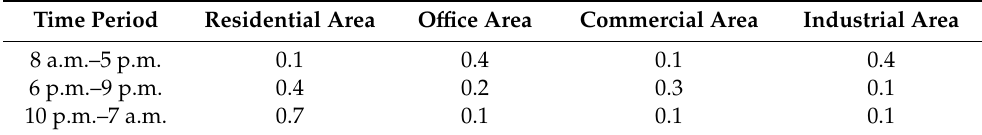
Table 2. Distribution probability of electric vehicles (EVs) in each time period for different functional areas. Time Period Residential Area O ffi ce Area Commercial